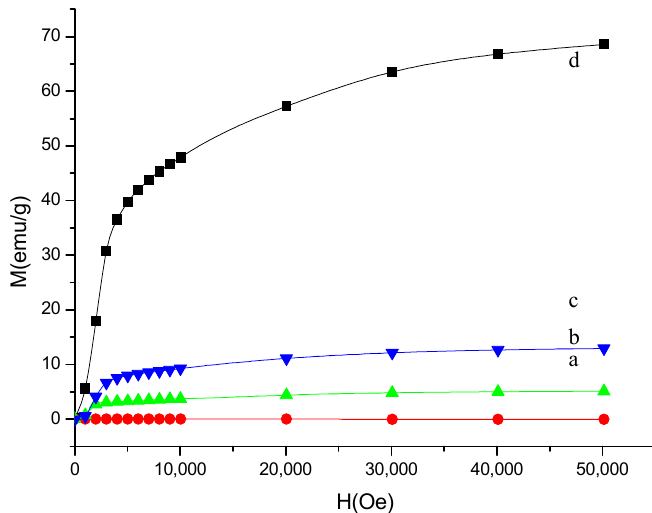
Figure 4. Magnetization curves of the PVA gel containing ( a ) 0% Ni; ( b ) 2.3% Ni; ( c ) 4.5% Ni; and ( d ) pure Ni nanoparticles. Coatings 2019 , 9 , x FOR PEER REVIEW